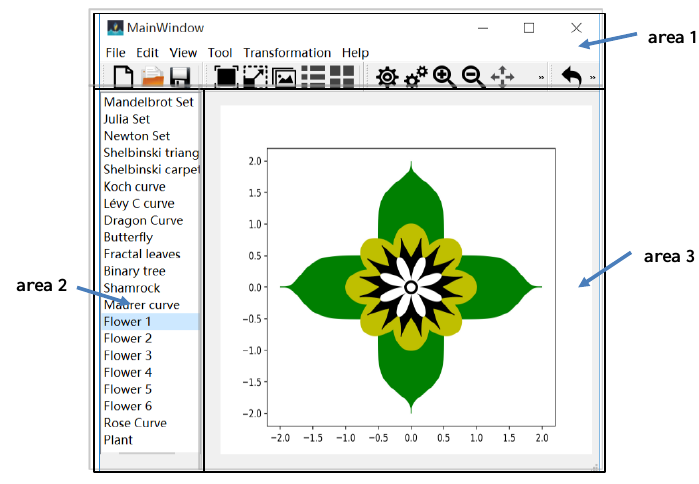
Figure 12. System work module.